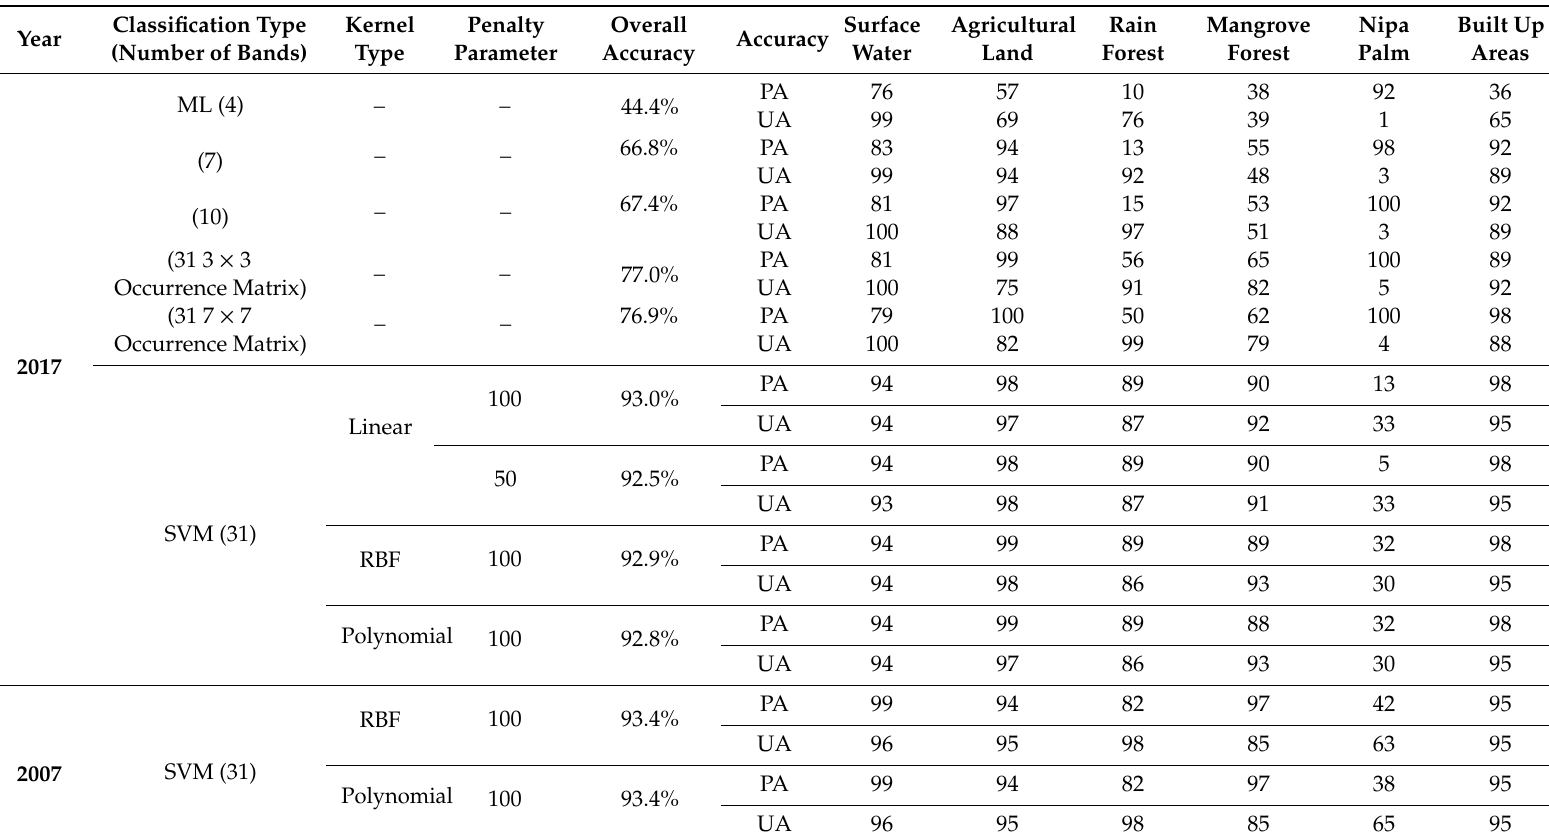
Table 3. LC classification accuracy (%) of 2007 and 2017 for the classification types showing individual accuracies of the land cover classes (see Section